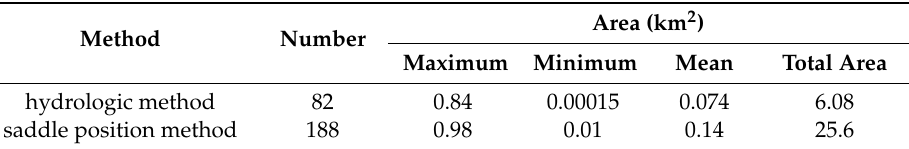
Figure 8. Depressions extracted using ( a ) saddle position method and ( b ) hydrologic analysis method. Table 3. Morphological characteristics of depressions using hydrologic method and saddle position